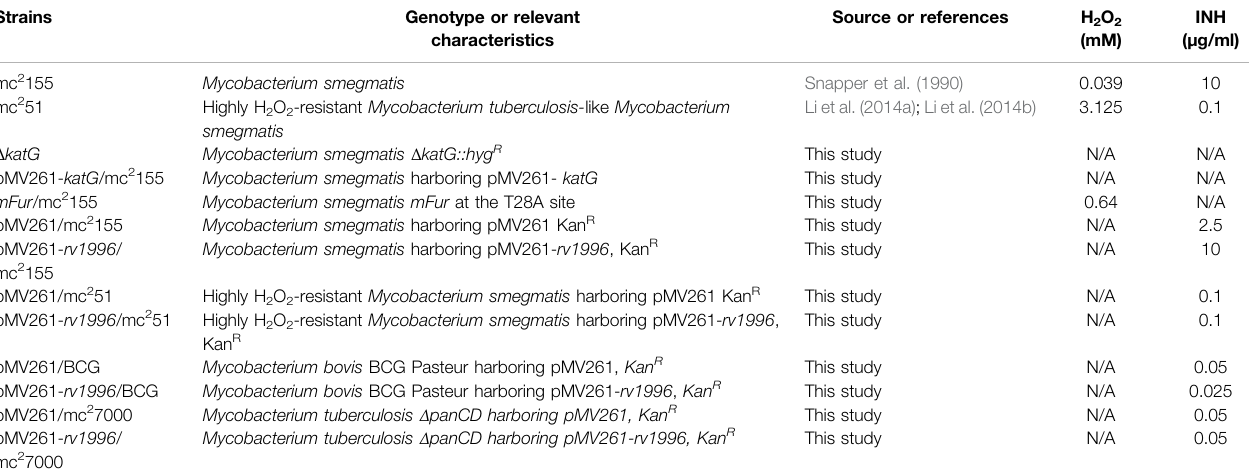
TABLE 1 | List of bacteria in this study. Strains